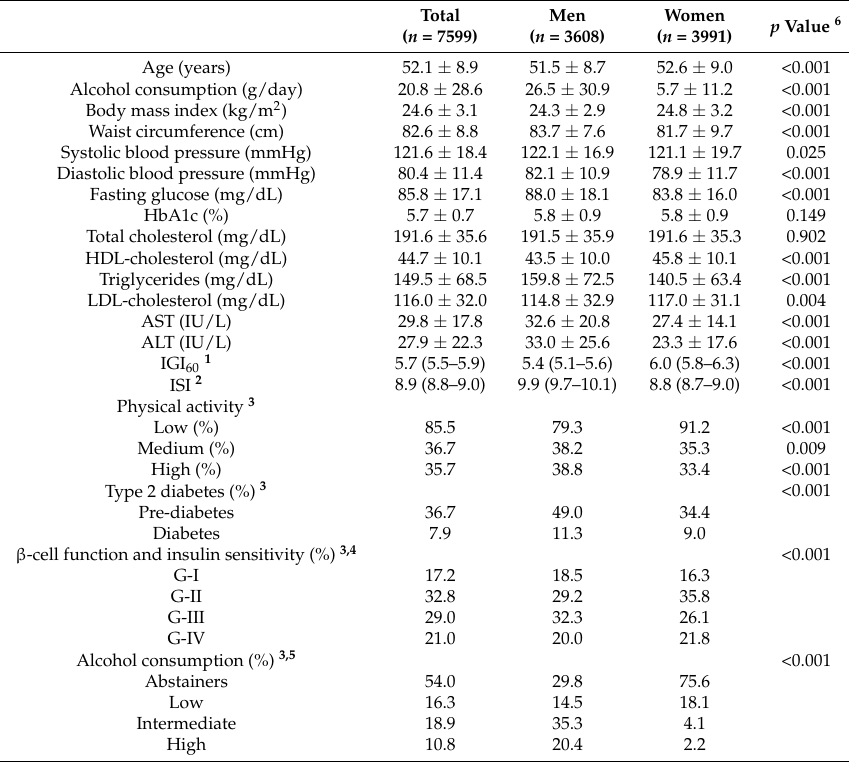
Table 1. General characteristics of Korean